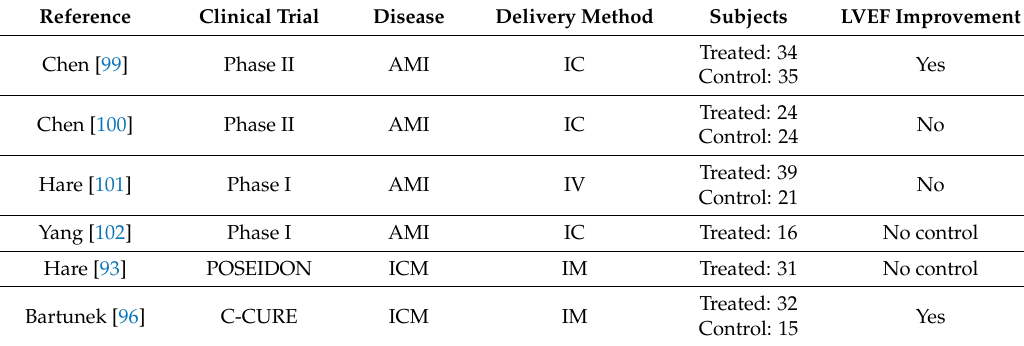
Table 5. Clinical trials with BM-MSCs for cardiac